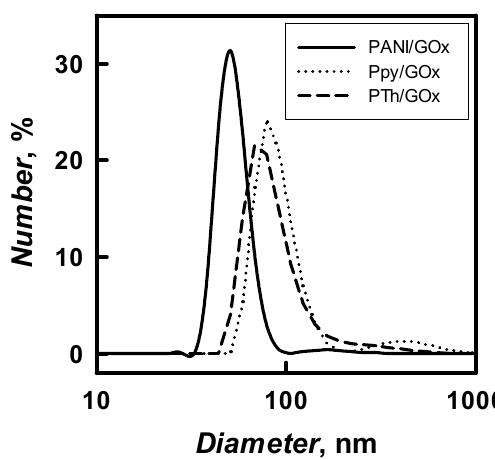
Figure 6. The distribution of PANI/GOx, Ppy/GOx, and PTh/GOx composite nanoparticles diameter. The particles were formed by 48 h lasting enzymatic polymerization at pH 6.0.